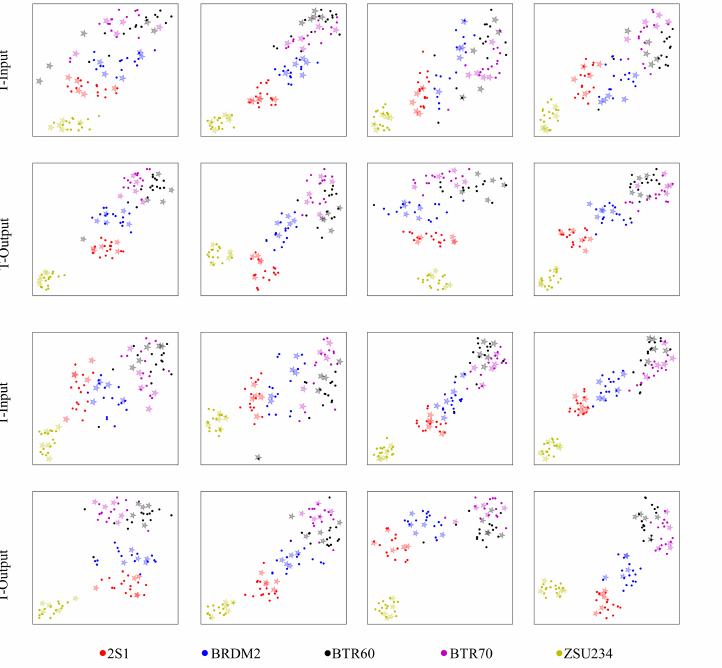
Figure 9. Visualization of the input features (the first and third rows) and output features (the second and last rows) of IAT under the 5 shot condition using t-SNE. Asterisks and dots represent the features of support images and query images, respectively. Different colors correspond to different categories.